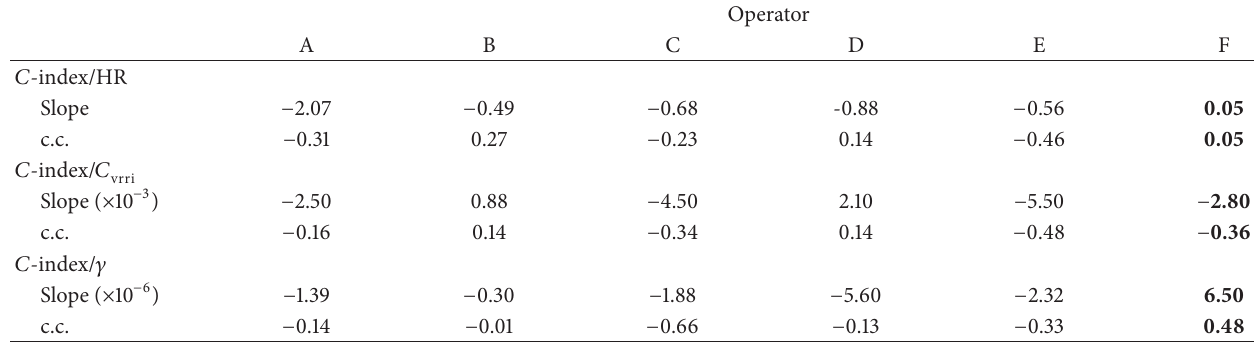
Table 5: Slopes of the regression lines and correlation coefficients in each relation with 𝐶 -index.